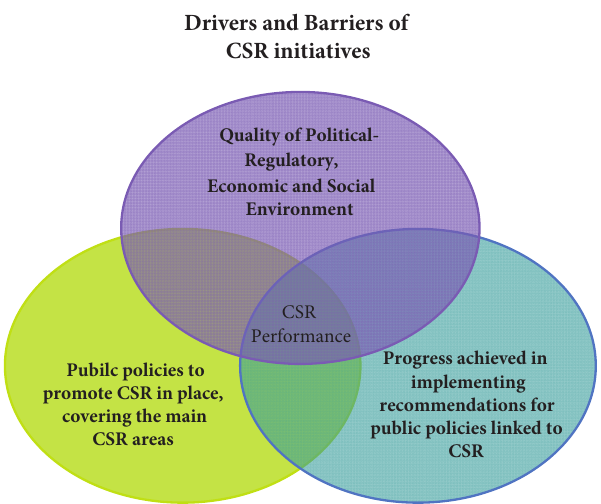
Figure 1. Conceptual framework of the study(source: created by the